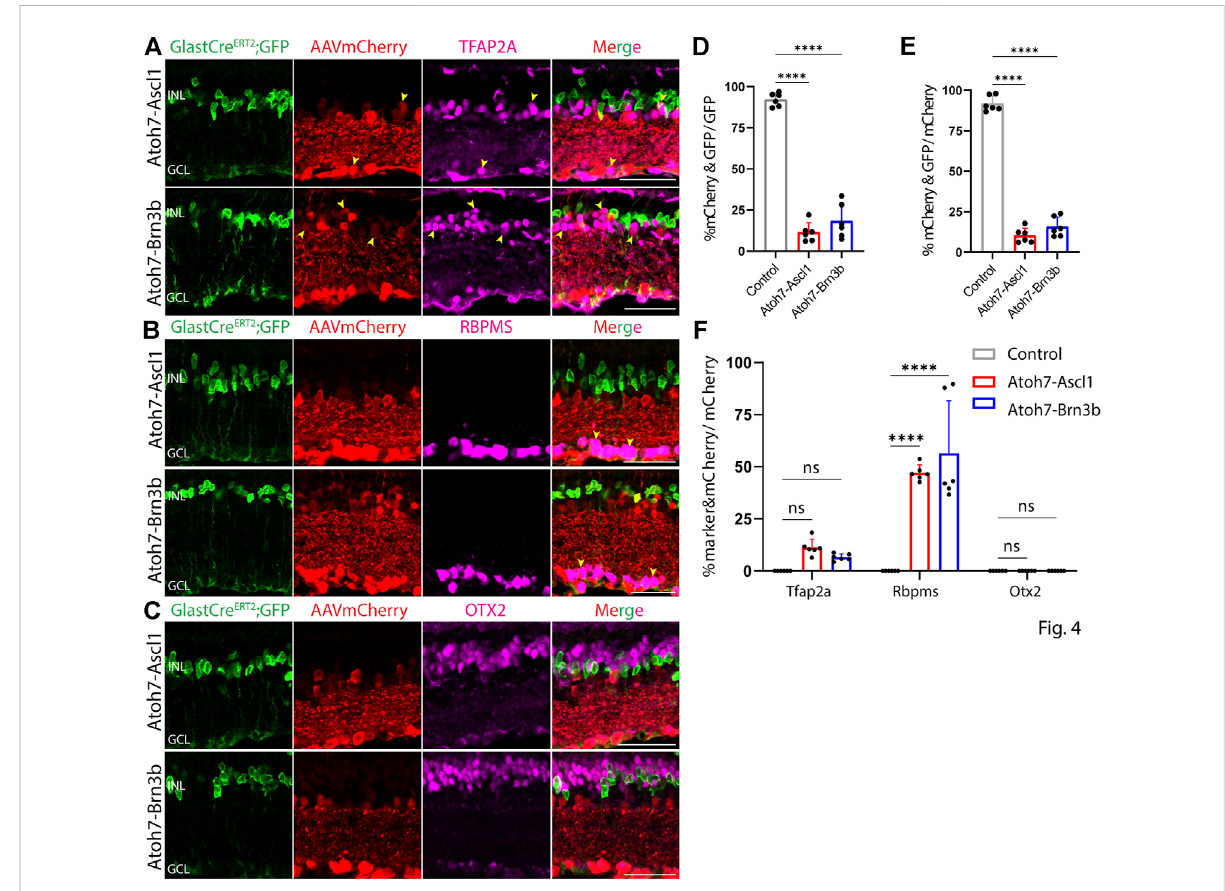
FIGURE 4 GFAP promoter constructs tandemly expressing Atoh7-Ascl1 and Atoh7-Brn3b show ectopic mCherry expression in amacrine and ganglion cells. Representative immunostaining for GFP, mCherry and 3 neuronal markers: (A) Tfap2a, (B) Rbpms, and (C) Otx2 expression in the retinas collected 21 days post GFAP AAV infection. GFAP-Atoh7-Ascl1-mCherry and GFAP-Atoh7-Brn3b-mCherry showed little to no colocalization of construct-derived mCherry and Müller glia-speci fi c Sun1-GFP. High levels of mCherry expression in amacrine and ganglion cells, but not in bipolar cells were observed in retinas infected with these GFAP AAV constructs. Yellow arrowheads indicate co-labeled mCherry+ & marker + cells. Quanti fi cation of transduction ef fi ciency (mCherry+ & GFP + cells/GFP + cells) (D) and transduction speci fi city (mCherry+ & GFP + cells/mCherry + cells) (E) . Quanti fi cation of mean percentage ±SD of marker & mCherry+/GFP cells: Tfap2a+ & mCherry+/GFP + cells (in INL and GCL), Rbpms+ & mCherry+/GFP+cells(inGCL)andOtx2+&mCherry+/GFP +cells(inINL) (F) .Signi fi cancewasdetermined via